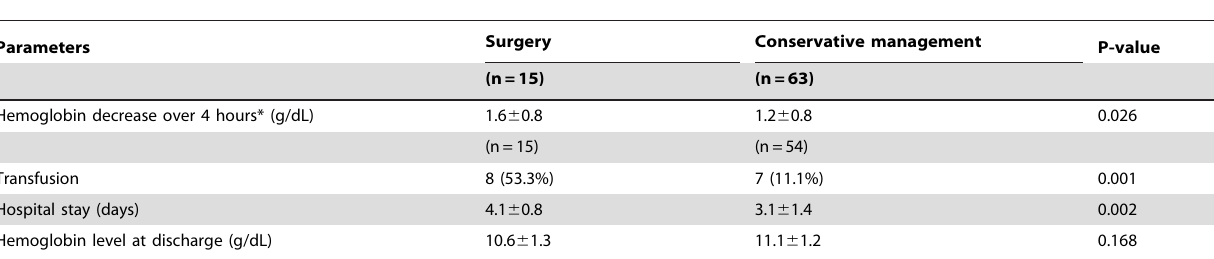
Table 3. Hospital course of the patients.